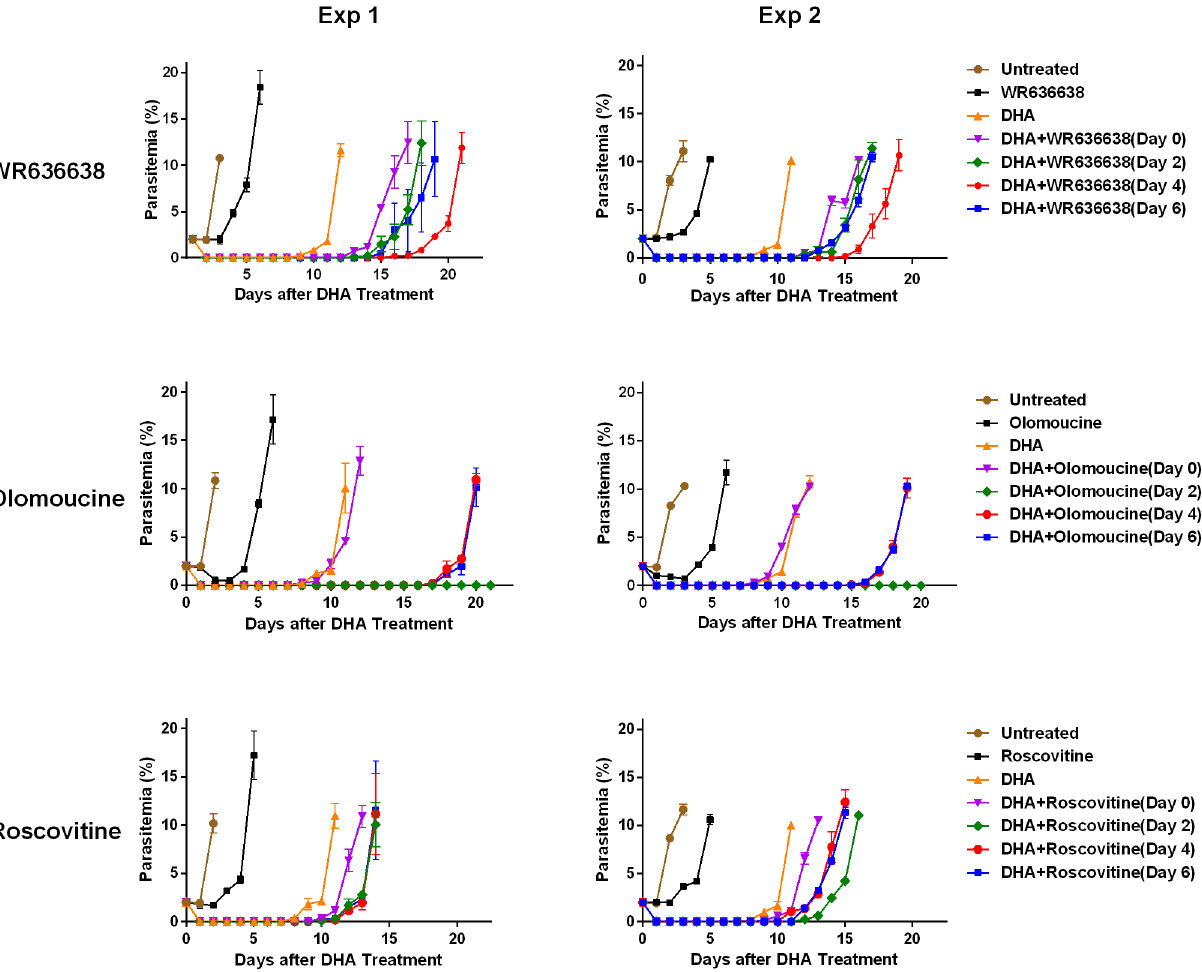
Fig 4. Effect of the CDK inhibitors (WR636638, olomoucineon and roscovitine) on untreated and DHA-treated W2 parasites. Parasites were treated with DHA alone for 6 h, or one of the CDK inhibitors alone for 48 h (at Day 0), or DHA (for 6 h) plus one of the CDK inhibitors (for 48 h). For DHA plus CDK inhibitors, one of the CDK inhibitors was added either together with DHA (Day 0) or after DHA treatment (Days 2, 4 and 6) for 48 h. Two panels (Exp 1 and Exp 2) represent results of 2 independent experiments, each in triplicate. Parasitemia (percentages of parasitized erythrocytes by morphologically normal parasites) was determined by